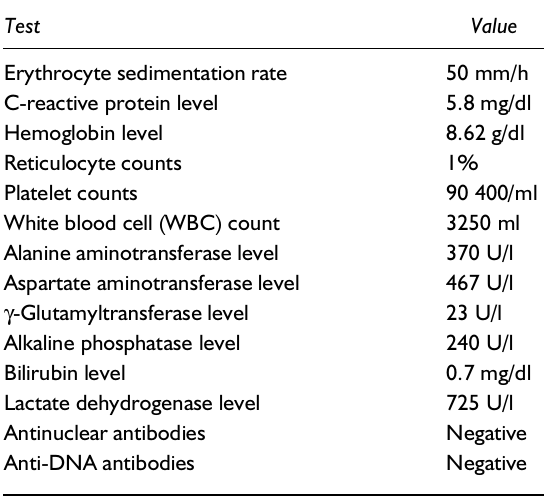
Table 1 Results of laboratory